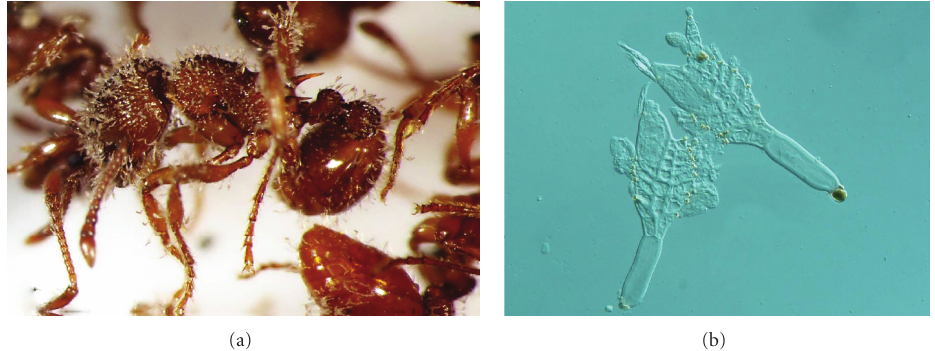
Figure 4: (a) Rickia wasmannii on Myrmica scabrinodis from Slovakia. Each “spatulate hair” is a thallus of Rickia . Photo by P. Bezd˘eˇcka; with permission; (b) two mature thalli. Spores are oozing out of the perithecium on the specimen from the right.